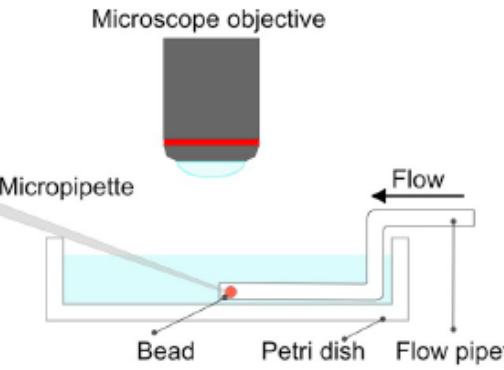
Figure 22. Schematic illustration of the micropipette-assisted microscopy set-up. The bead is positioned inside the flow pipette with a micropipette and the suction of a microinjector enables holding of the bead. The bead is monitored using light or fluorescence microscopy. Acknowledgement: